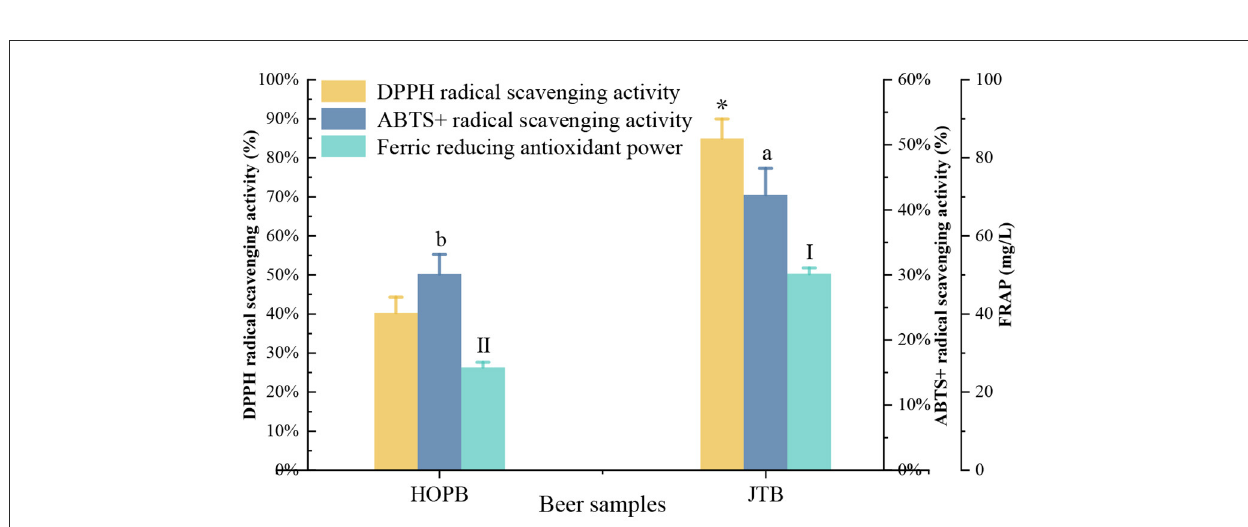
FIGURE7 Antioxidant activity and polyphenol content. “a, b, I, II” and “ * ” Different letters in the same indexes indicate significant differences between mean values ( p < 0.05). ABTS, 2,2 ′ -azino-bis (3-ethylbenzothiazoline-6-sulphonic acid); DPPH, 2,2-diphenyl-1-picrylhydrazyl; FRAP, ferric reducing antioxidant